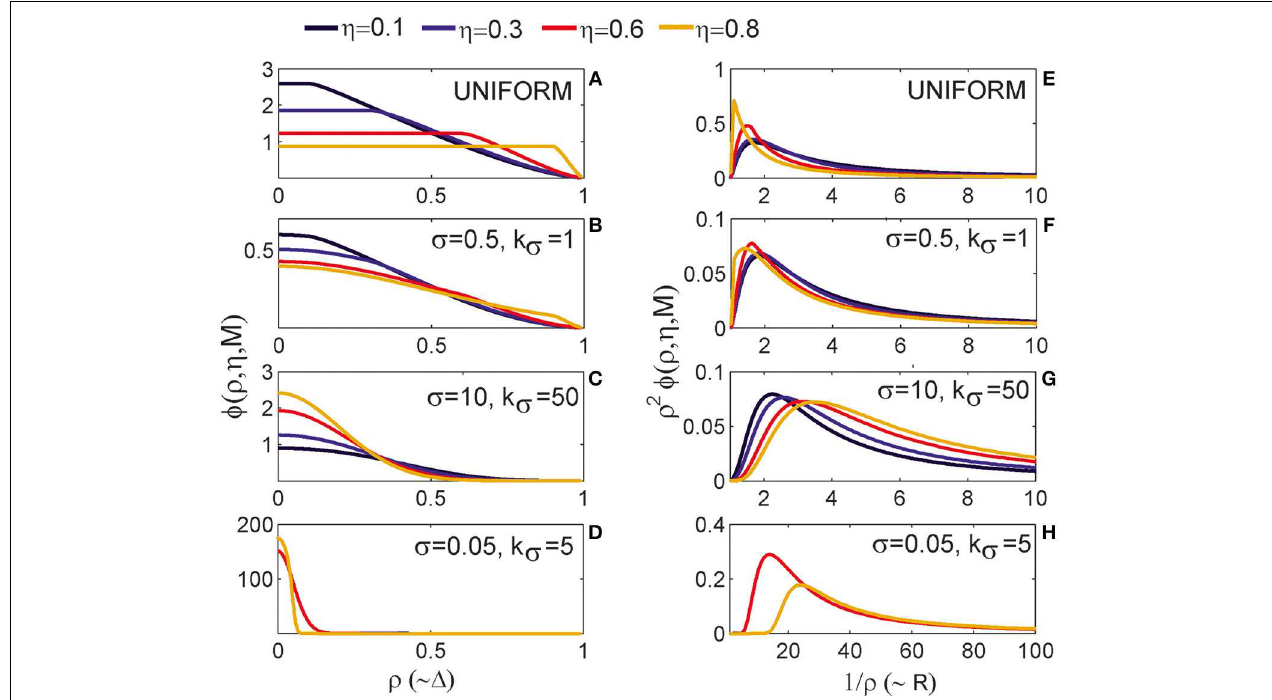
FIGURE 4 | Expected number of synapses. Left column: Distance-dependent expected number of synapses [ φ ( ρ,η, M ) ] as a function of the axon-dendrite distance ( 1 ), and consequently the normalized axon-dendrite distance ( ρ ) . When all the parameters but 1 are fixed this function is equal to the expected number of synapses up to a multiplicative constant. Right column: Size-dependent expected number of synapses [ ρ 2 φ ( ρ,η, M ) ] as function of the average neurite radius R and the inverse of the normalized axon-dendrite distance ( 1 /ρ ) which is proportional to the